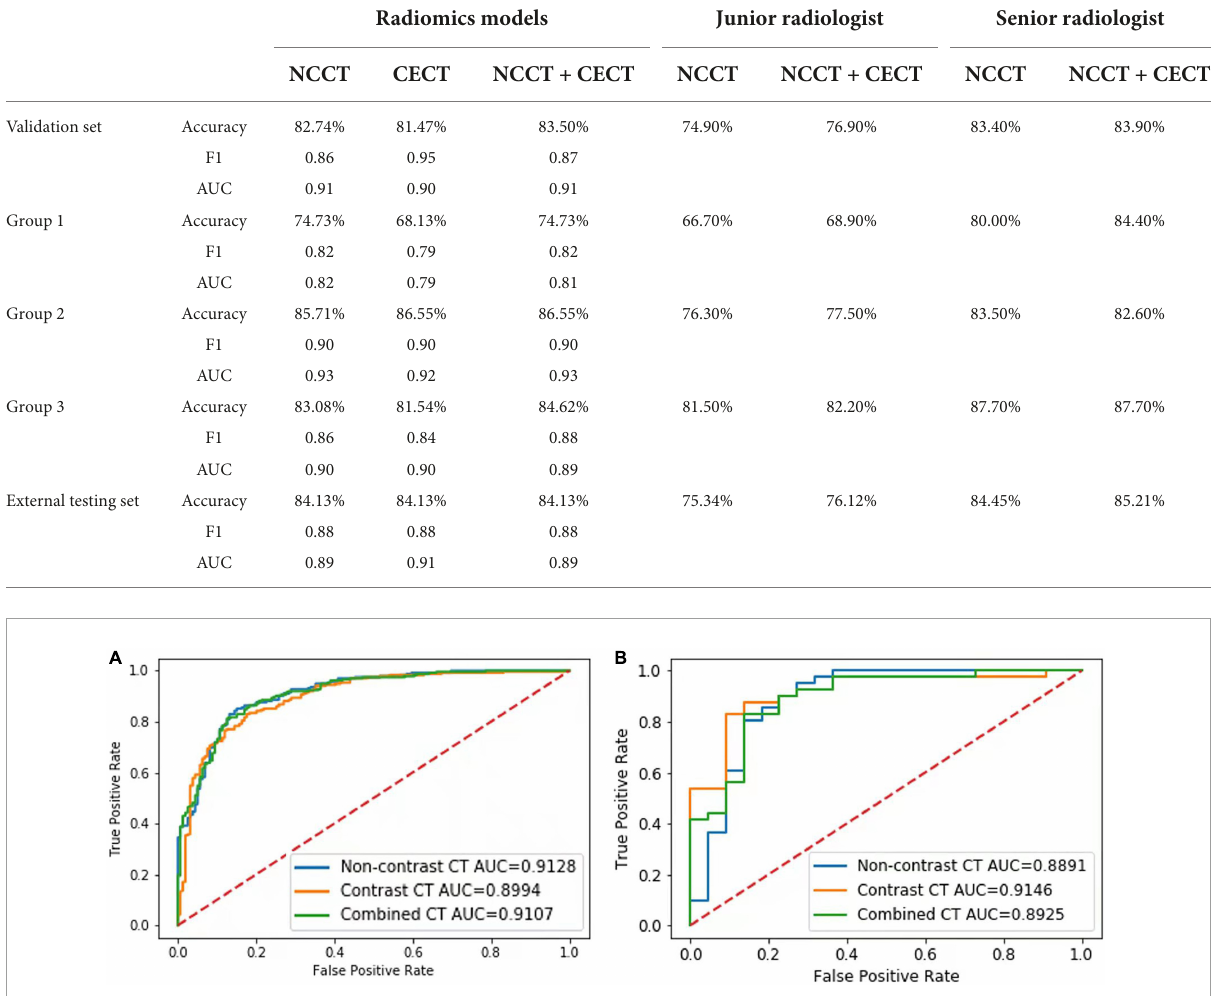
0.93, 0.92, and 0.93, respectively ( Figure 3B ). The results of Top 10 features of the non-contrast